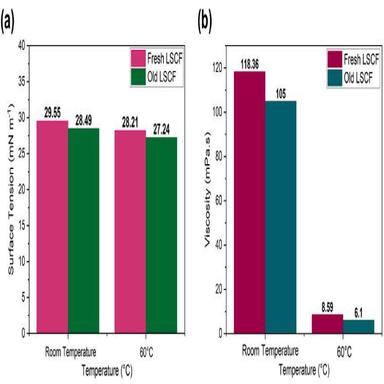
Rheological characterization of fresh and old LSCF inks. (a) viscosity and (b) surface tension measurements at room and printing temperature (60 ◦C).